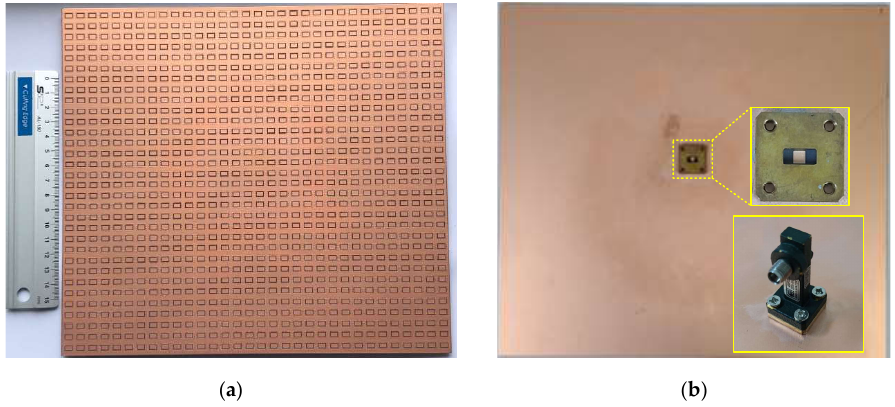
Figure 9. Photograph of the fabricated 32 × 32 array antenna. ( a ) Top view. ( b ) Back view. Figure 10a,b exhibit the experimental results of |S11|, gain, and radiation efficiency.